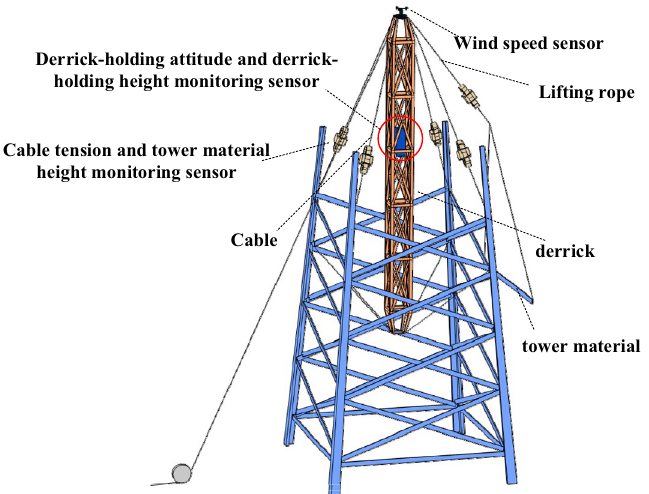
Figure 1. Schematic diagram of system monitoring point setting.